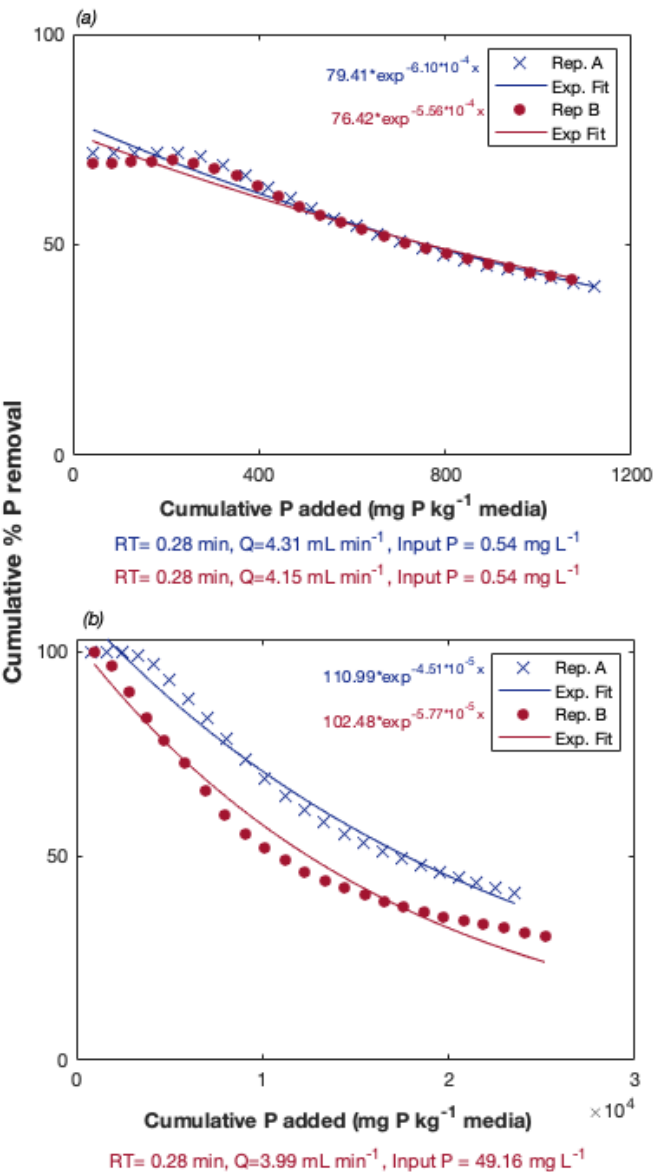
Figure 4. Preliminary evaluation of phosphorus (P) removal ability of PhosRedeem in flow-through experiments conducted at a residence time (RT) of 0.28 min and inflow P concentrations of ( a ) 0.5 mg L − 1 and ( b ) 50 mg L − 1 . Cumulative P removal is plotted as a function of cumulative P